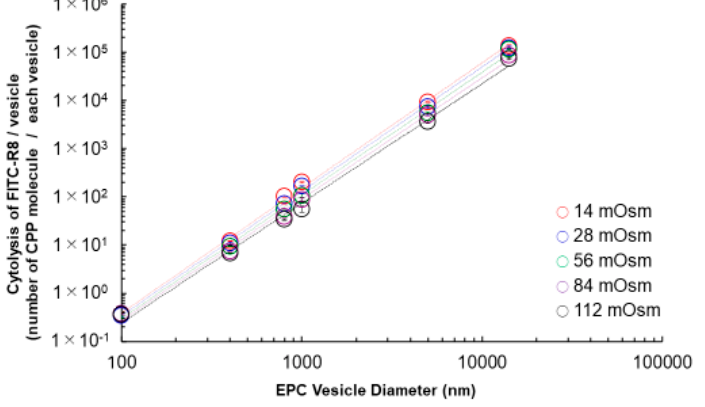
Figure 4. E ff ect of osmotic pressure for FITC–R8 cytolysis vs. EPC vesicle size. L / P = 1000, 37 ◦ C, 10 Figure 4. Effect of osmotic pressure for FITC–R8 cytolysis vs. EPC vesicle size. L/P = 1000, 37 °C, 10 min, n = 3; cytolysis amount of FITC–R8 (CPP) / vesicle (number of CPP molecule / each min, n = 3; cytolysis amount of FITC–R8 (CPP)/vesicle (number of CPP molecule/each vesicle).